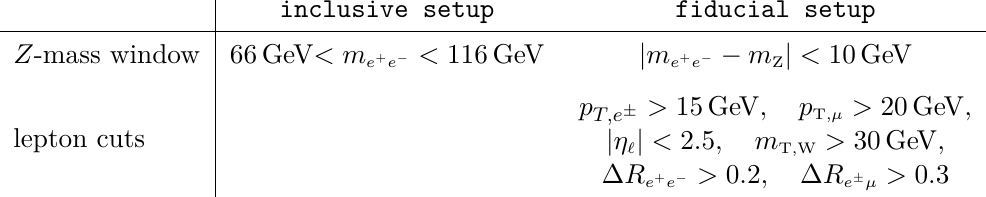
Table 1. Inclusive and fiducial cuts used to define the phase space regions of the inclusive setup and the fiducial setup [7]. Note that e ± and µ refer to dressed